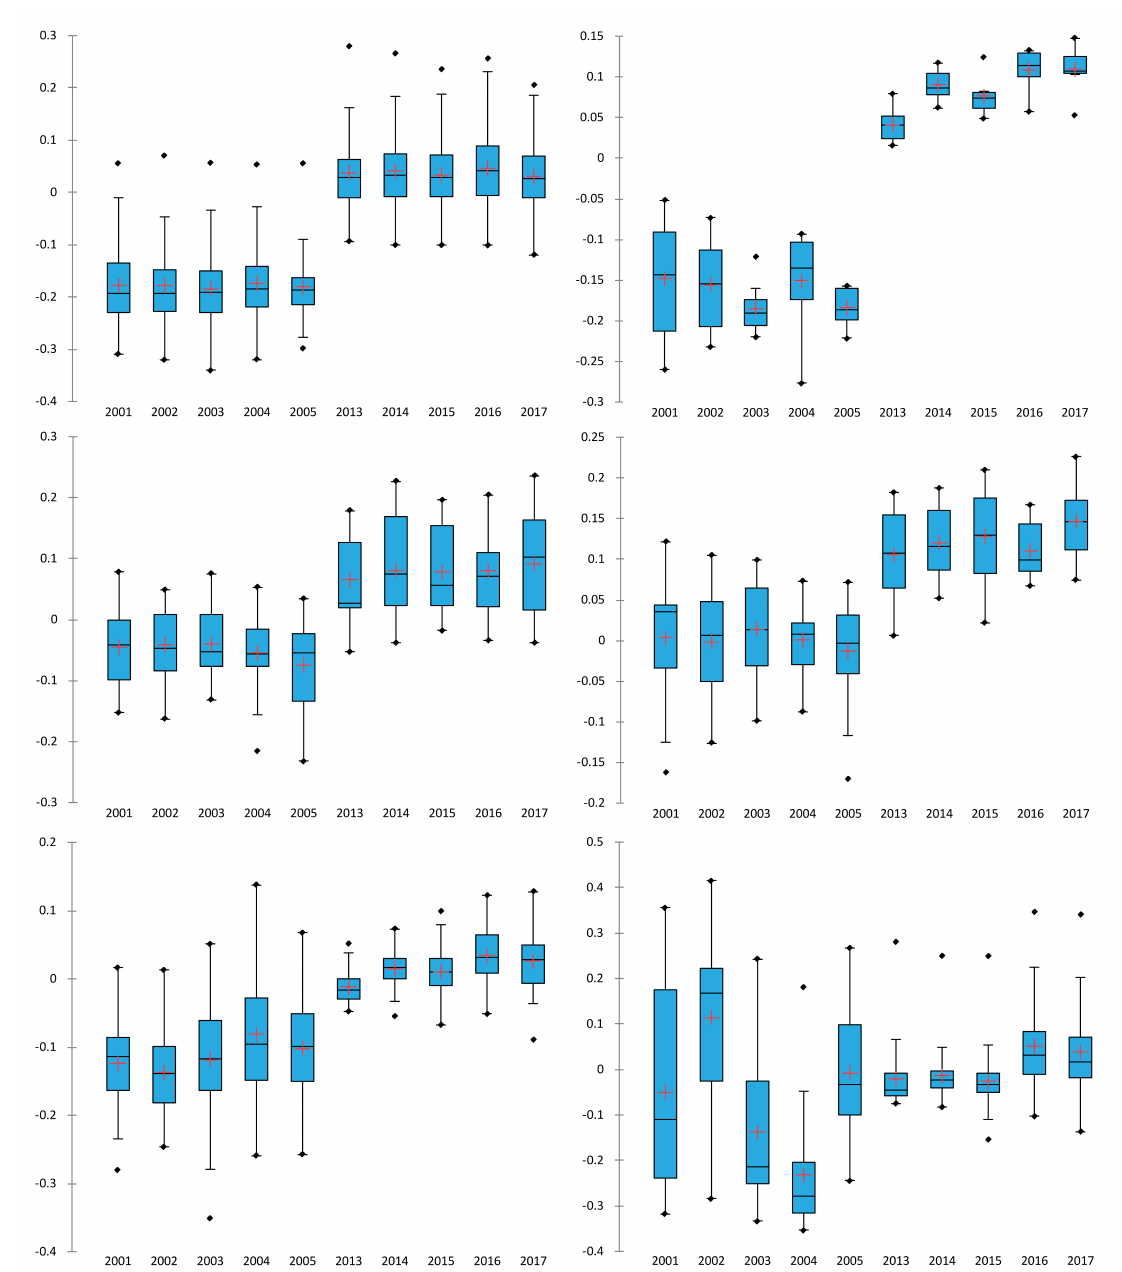
Figure 11. NDMI boxplots for the six sites: Confluence ( top-left ), Kaplan Park ( top-right ), dock ( middle-left ), Garibadi Street ( middle-right ), Museum ( bottom-left ), and Groupama Stadium ( bottom-right ); red cross: average; black dots: min and max